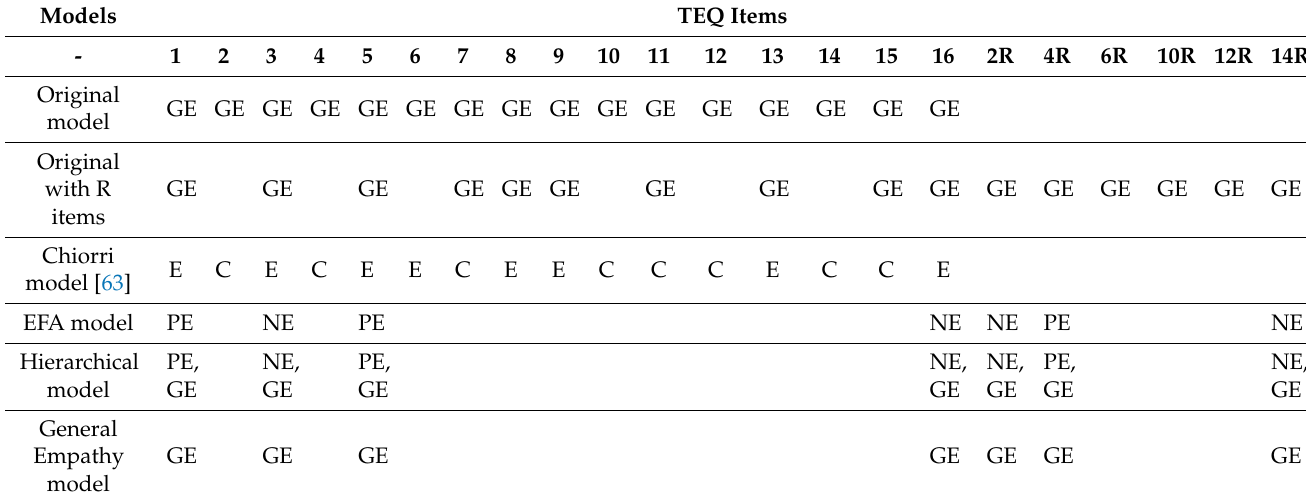
Table 3. Item composition of the tested